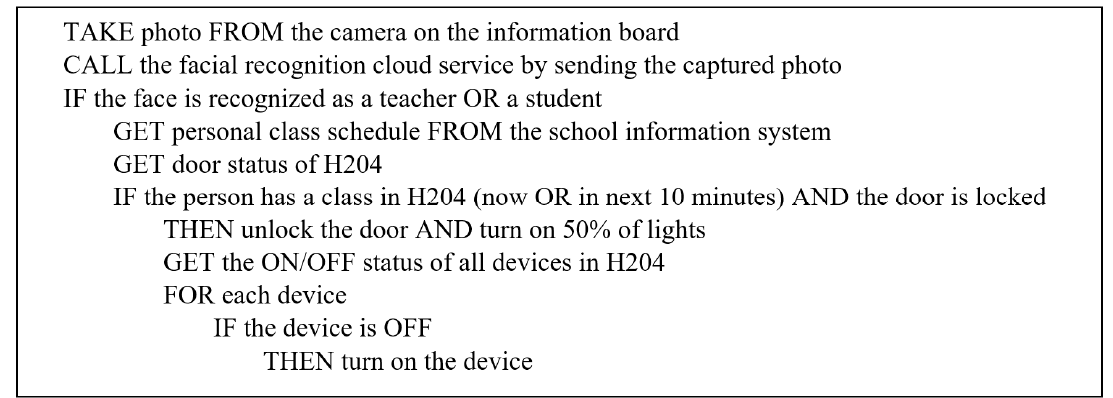
Figure 15. A facial recognition door access control procedure for smart classroom.